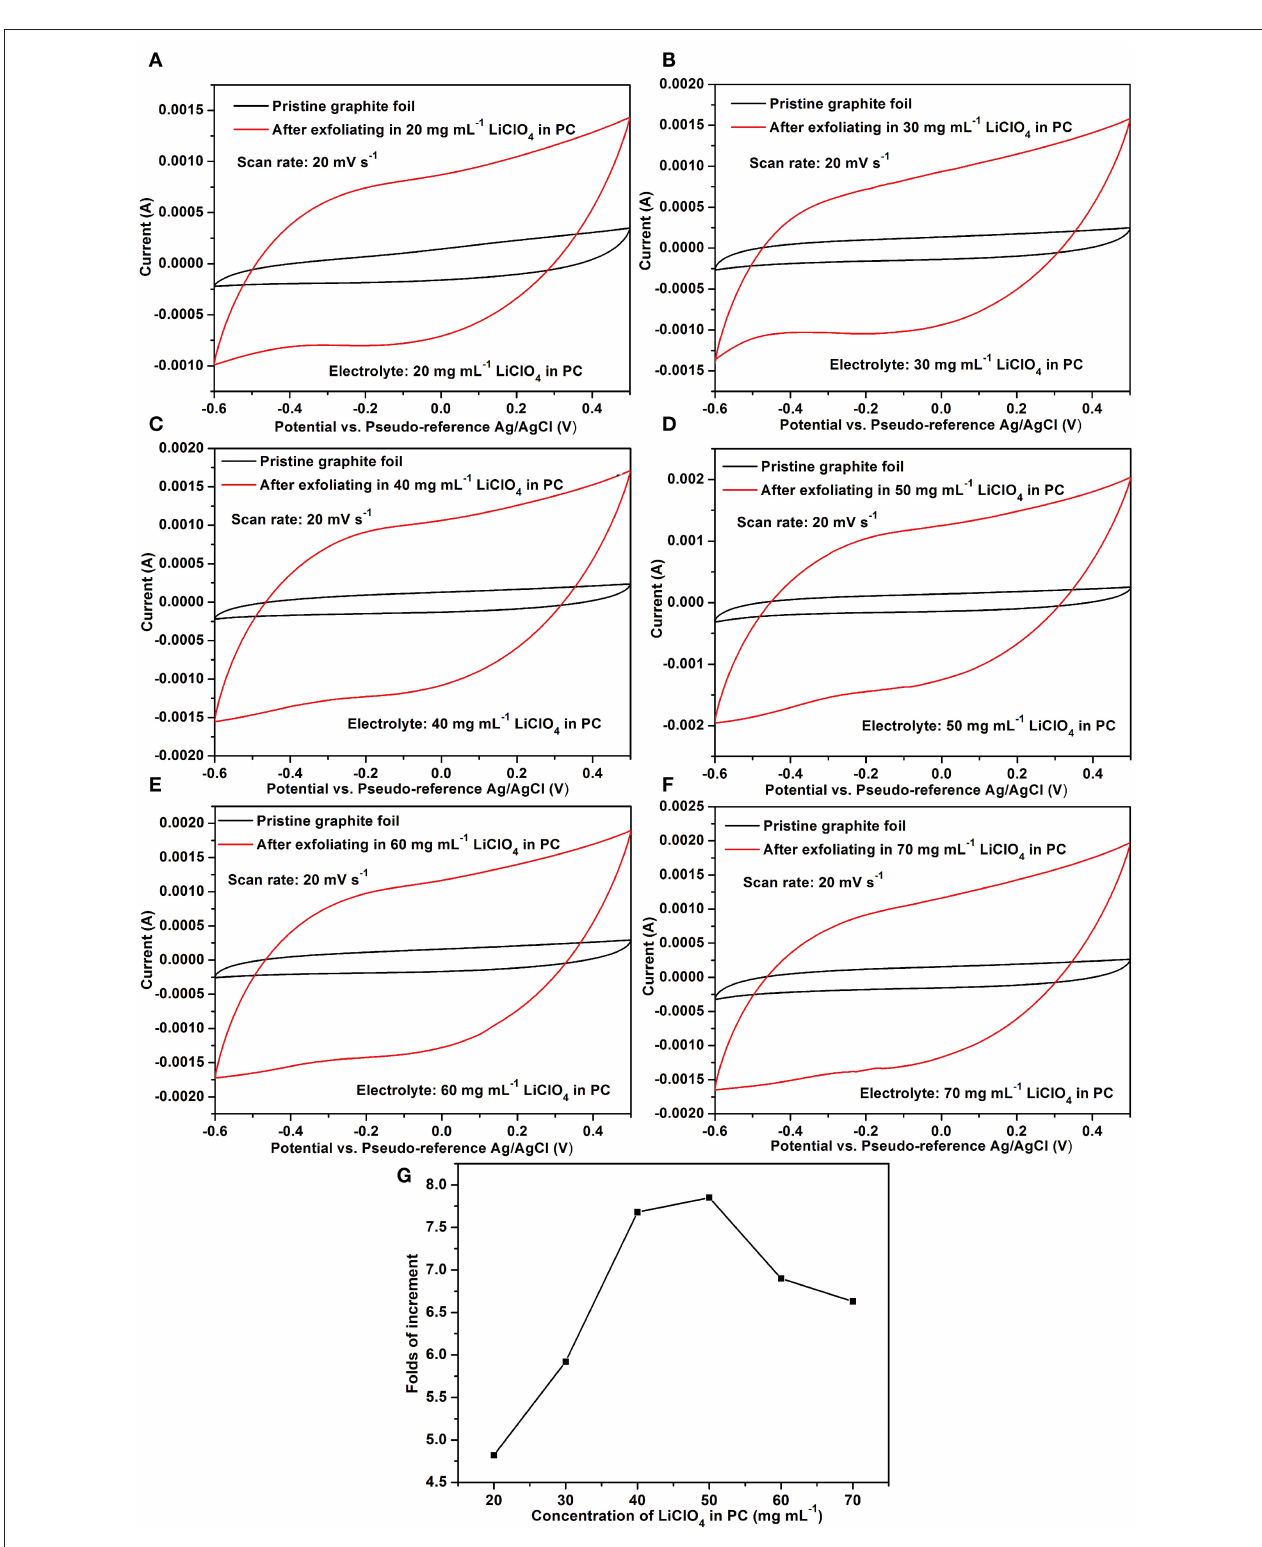
FIGURE 3 | (A–F) Comparison of electrochemical exfoliation for graphite foil with various concentrations of LiClO 4 in PC solvents; (G) the folds of increment of the double-layer capacitance along with the concentration of LiClO 4 .